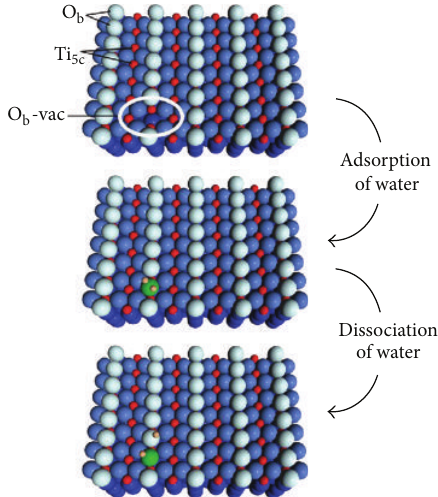
Figure 12: The dissociation of water in bridging oxygen vacancy. Green spheres denote O atoms with two H pink spheres